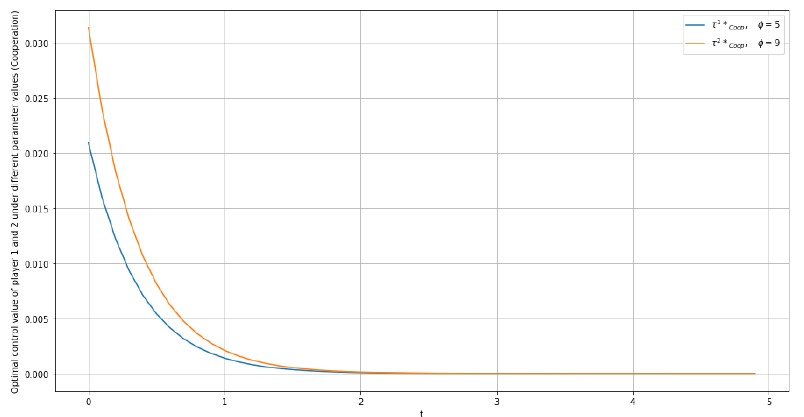
Figure 11. The optimal controls of two players under Nash equilibrium and different φ